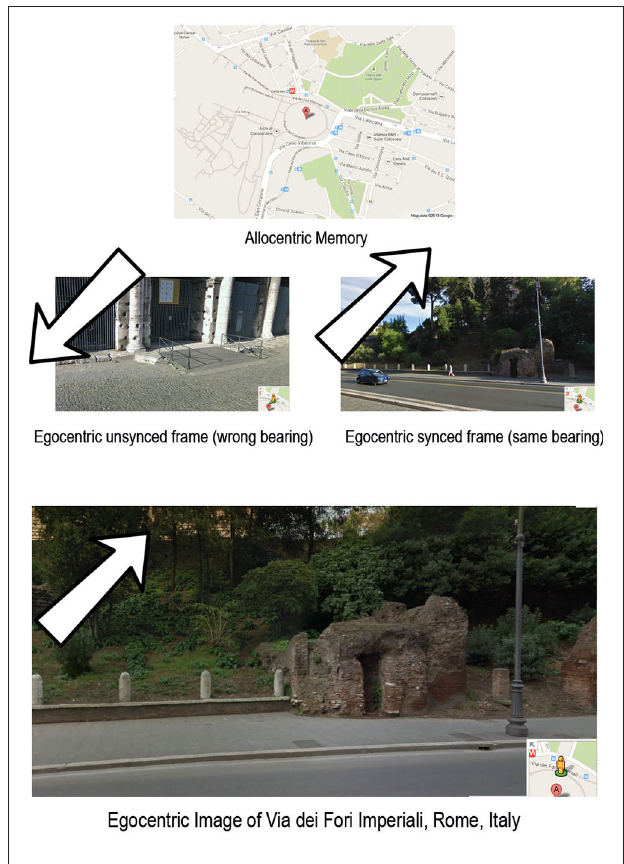
FIGURE 2 | The “mental frame syncing” may be defined as a neurocognitive process that allows an effective retrieval of our past experiences by synchronizing the view-point independent representation with the allocentric view-point dependent representation . If the mental frame syncing stops, the reconstructed scenario is useless because the view-point is not similar to those that had activated the episodic